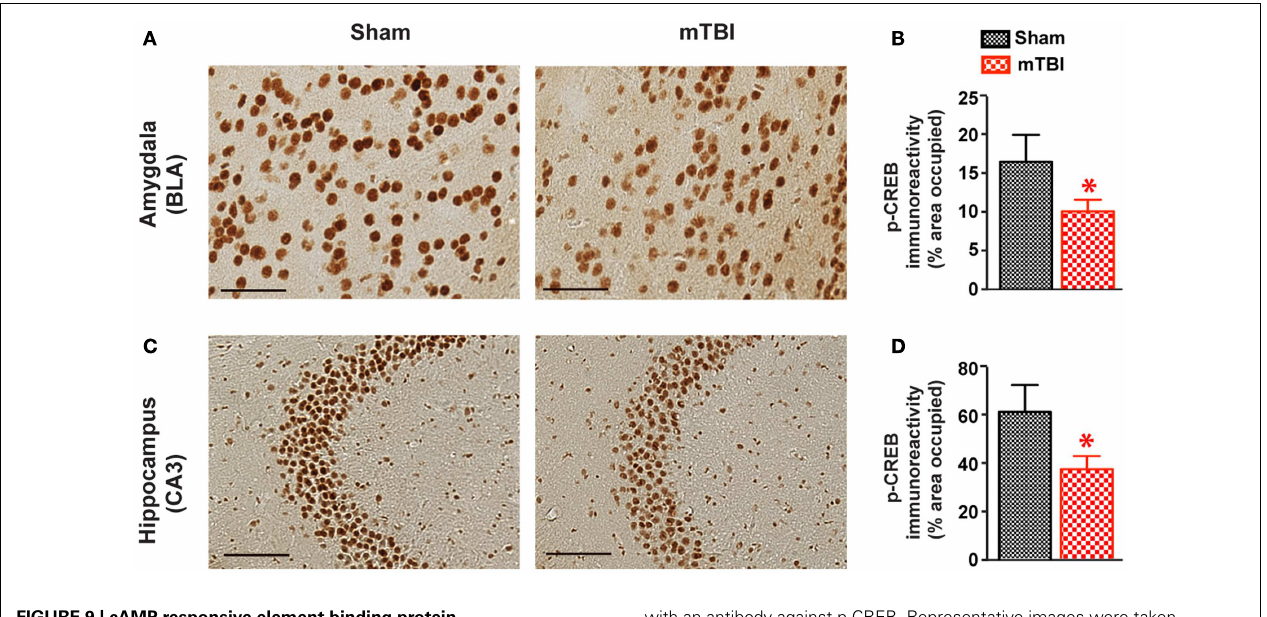
FIGURE 9 | cAMP responsive element binding protein phosphorylation was significant reduced after repetitive mTBI . Wild-type C57BL/6J mice (male, 3months of age) received three mild impacts (mTBI) or underwent sham procedures (sham). Mice were sacrificed 6months later and brains were fixed for immunohistochemistry